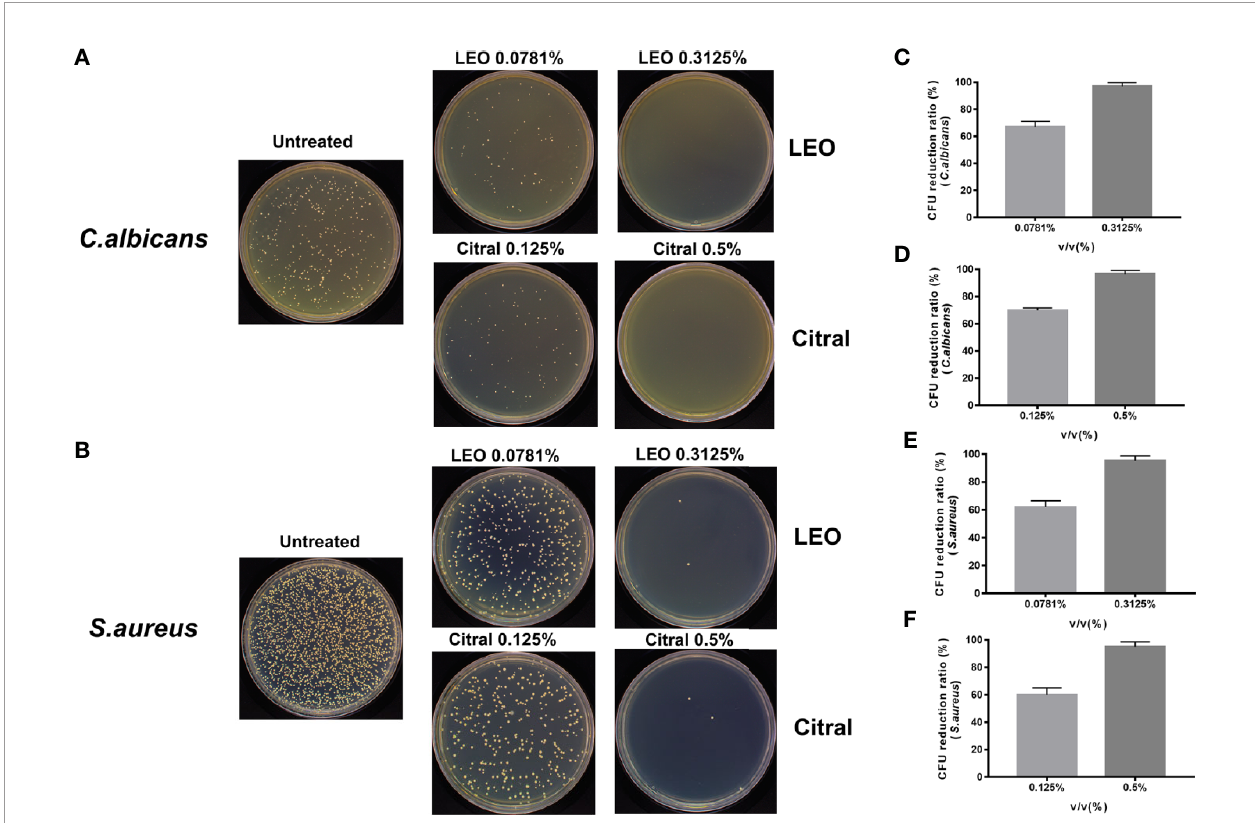
FIGURE 4 | Antimicrobial effects of lemongrass essential oil or citral on the viability of residing species within dual-species bio fi lms. (A) Representative images of Candida CFU after 24 h treatment. (B) Representative images of staphylococcal CFU after 24 h treatment. (C) Comparison of the CFU treated by different concentrations of lemongrass essential oil and untreated CFU of C. albicans . (D) Comparison of the CFU treated by different concentrations of citral and untreated CFU of C. albicans . (E) Comparison of the CFU treated by different concentrations of LEO and untreated CFU of S. aureus . (F) Comparison of the CFU treated by different concentrations of citral and untreated CFU of S. aureus . LEO, lemongrass essential